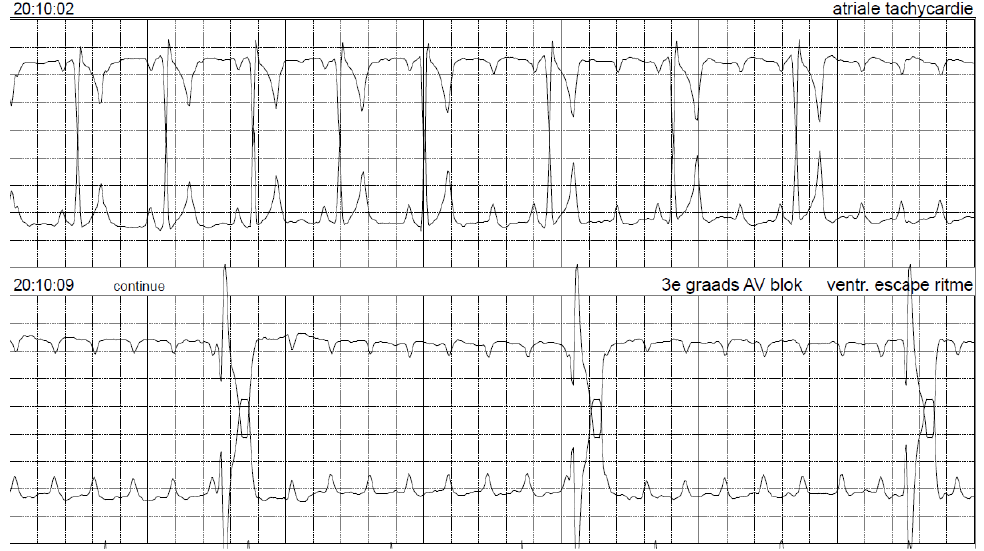
Figure 8. Holter electrocardiogram while the pacemaker was switched off (OOO mode) shows sinus rhythm, which turns into second- and then third-degree atrio-ventricular block. Paper speed 25 mm/s.